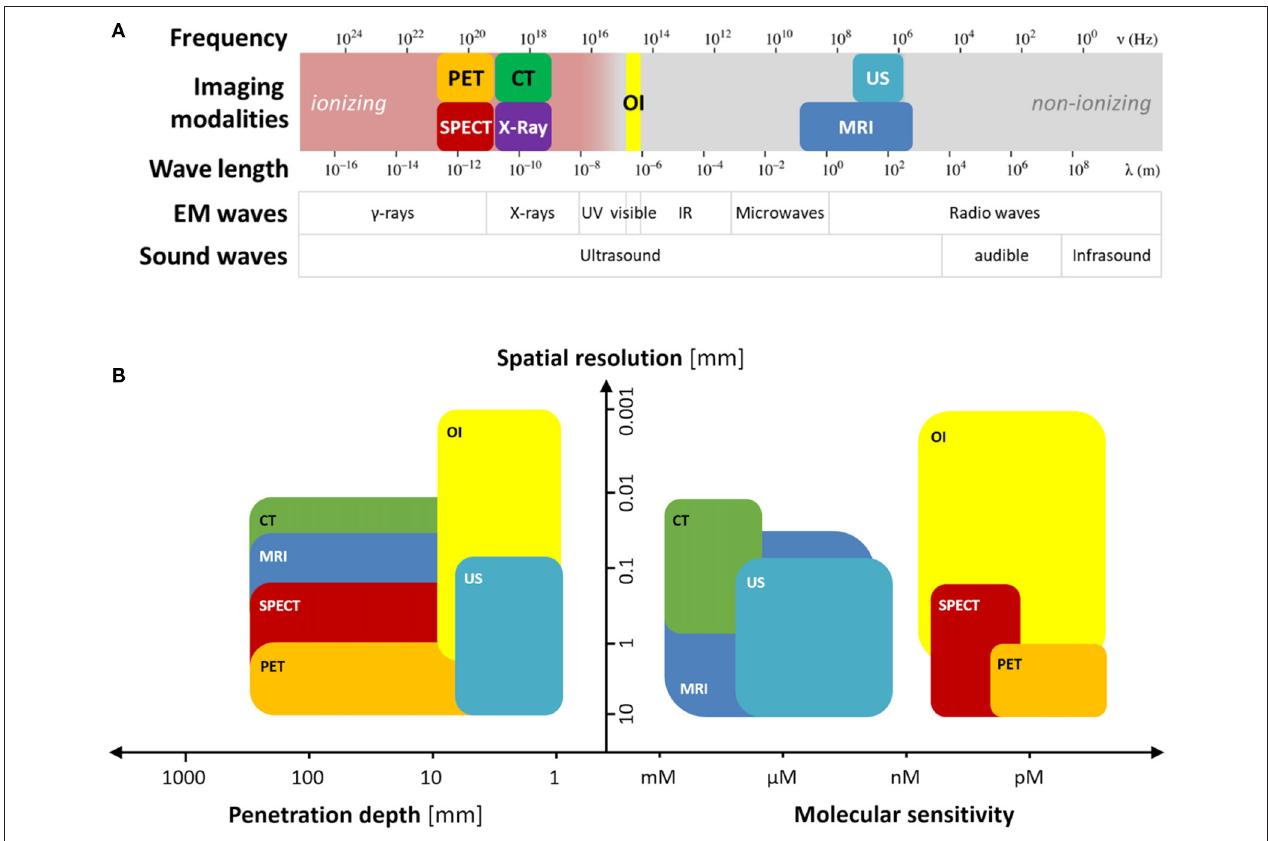
FIGURE 2 | (A) Electromagnetic frequency spectrum with indications for frequency ranges employed for various imaging modalities. (B) Key imaging performance illustrated for most clinical imaging modalities as a function of spatial resolution, penetration depth into tissue (left) and molecular sensitivity. The same color code as that in Figure 1 is